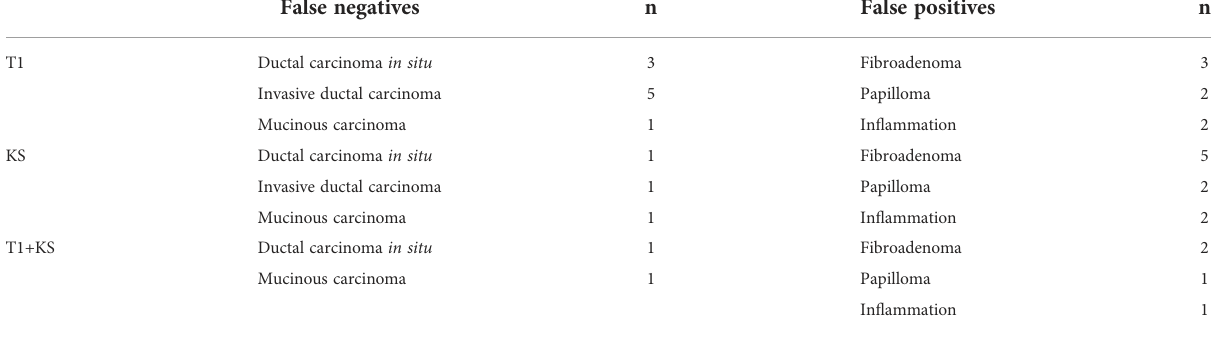
TABLE 4 Detailed information of the false-negative and false-positive lesions diagnosed by T1, KS, and their combination. False negatives n False positives n